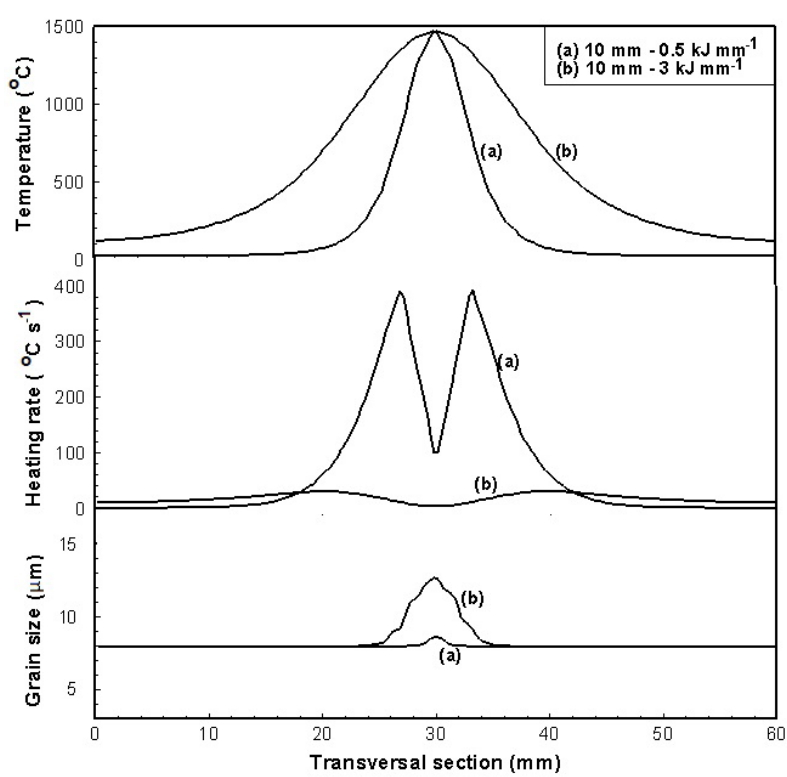
Figure 14 - Grain growth versus heating rate: (a) 0.5 kJ mm -1 (10 mm) and (b) 3 kJ mm -1 (10